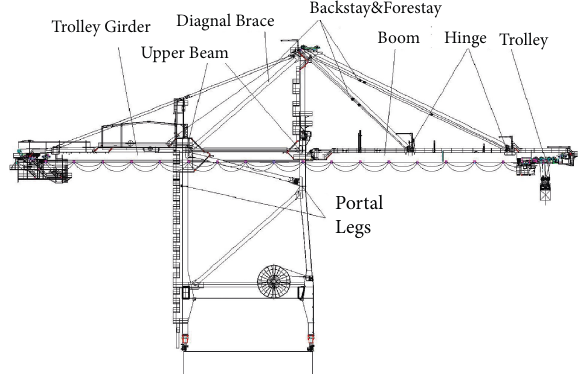
Figure 1: Metallic structure of quay